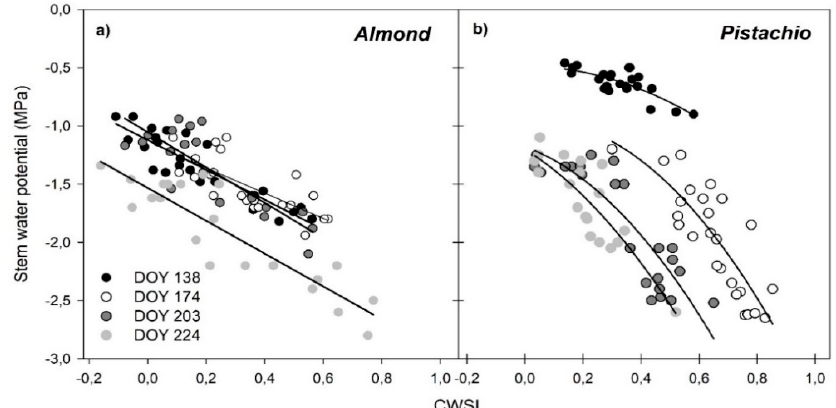
Figure 8. Seasonal relationships between the remotely-sensed CWSI and measured stem water potential ( Ψ stem ) for ( a ) almond and ( b ) pistachio trees, corresponding to dates of 17 th May (DOY 138), 22 June (DOY 174), 21 July (DOY 203), and 11 August (DOY 224). Equations and coefficients of determination (r 2 ) of the regressions were as follows: in almond, y = − 1.281 x − 1.122, R 2 = 0.82 (DOY 138), y = − 1.084 x − 1.144, R 2 = 0.54 (DOY 174), y = − 1.517 x − 1.054, R 2 = 0.70 (DOY 203), y = − 1.409 x −